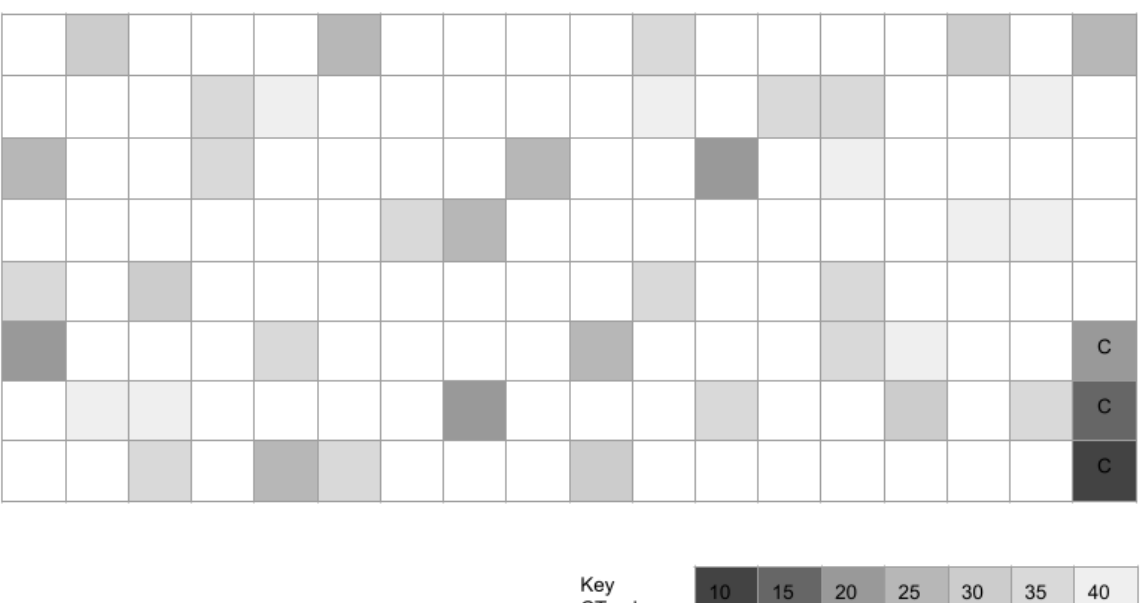
Figure 1. Heat map of qPCR pediatric study sample screening for Akkermansia muciniphila (AM). This screening revealed n = 42/141 or 29.8% of samples harbored DNA specific for AM. The majority of these samples ( n = 28/42 or 66.7%) exhibited AM-specific DNA levels corresponding to low (C36–C40) or moderately low (C31–C35) cycle threshold detection values. C = positive control standard curve data for 16S rRNA.